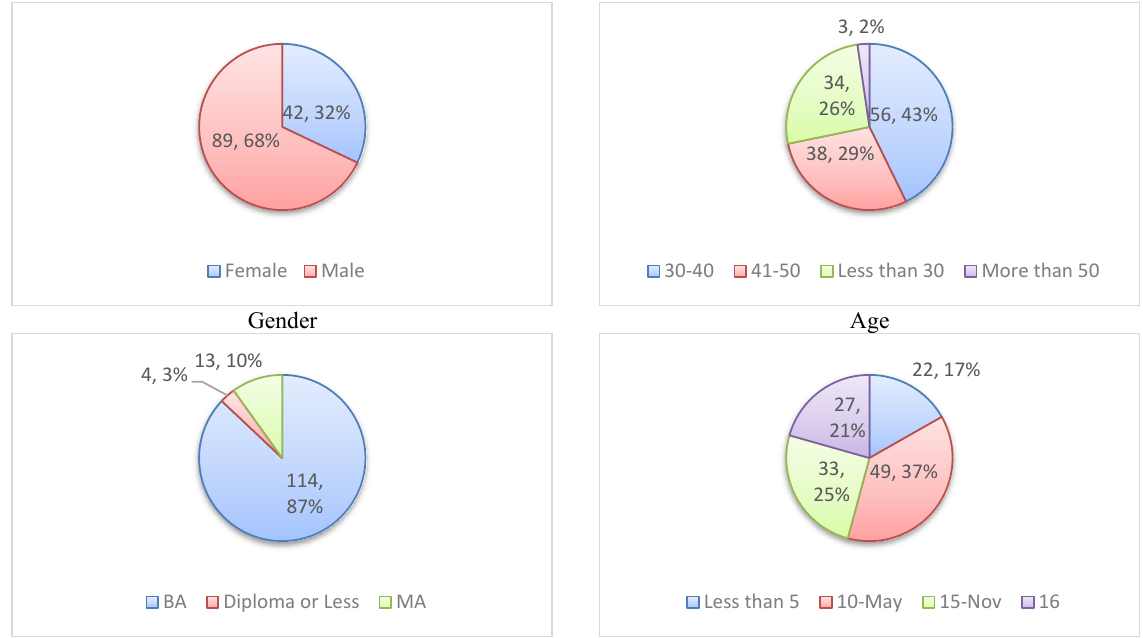
Fig. 2. Personal characteristics of the